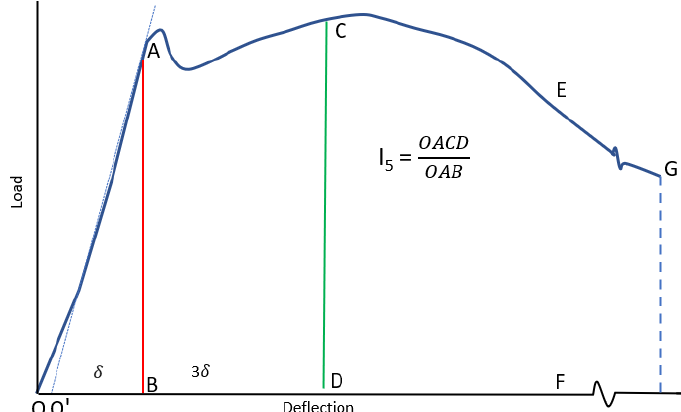
Figure 8. Toughness index calculation.